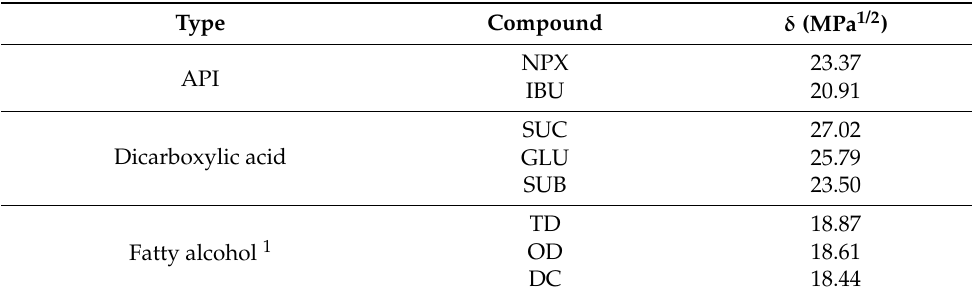
Table 1. Solubility parameter ( δ ) values of APIs, dicarboxylic acids, and fatty alcohols.